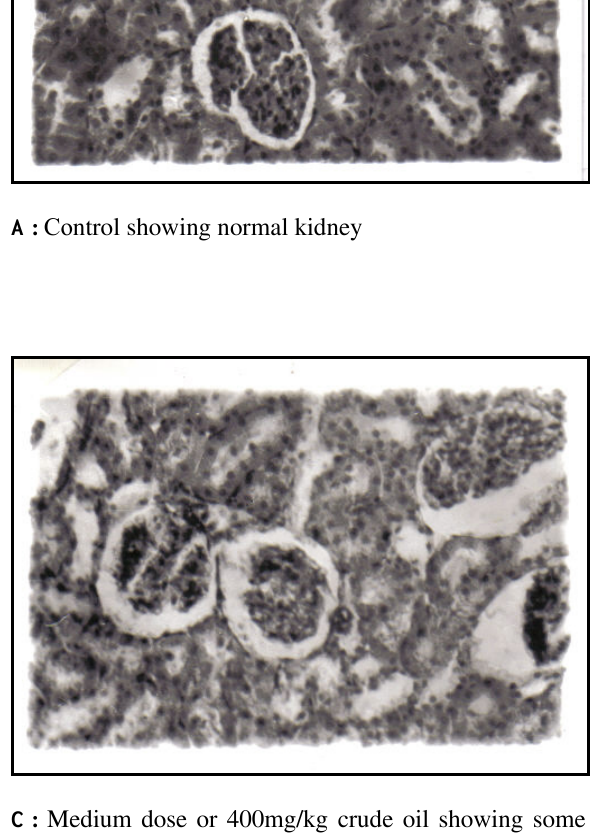
nephrotoxicants, with nephrotoxicity defined as increased kidney weight (absolute or relative)